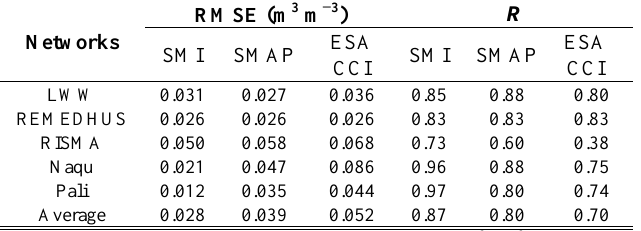
Table 3. Root mean square error (RMSE, in m 3 m −3 ) and correlation coefficient ( R , p-value < 0.05) of SMI, SMAP and ESA CCI with ground observations from the five networks during the whole study period. The cumulative distribution function (CDF) of all these products is rescaled to that of in situ soil